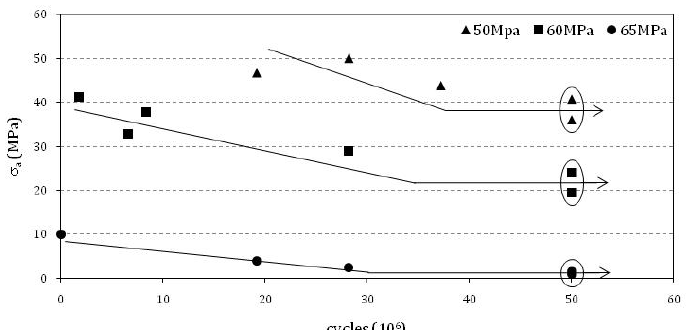
Figure 12: Experimental results of tensile fatigue tests in S-N diagram for three values of mean stress; specimens marked with an arrow do not fail.